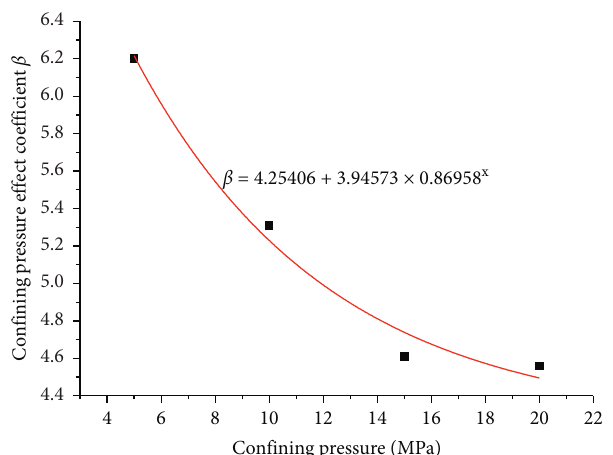
Figure 6: Relation curve between confining pressure effect coefficient and confining pressure.